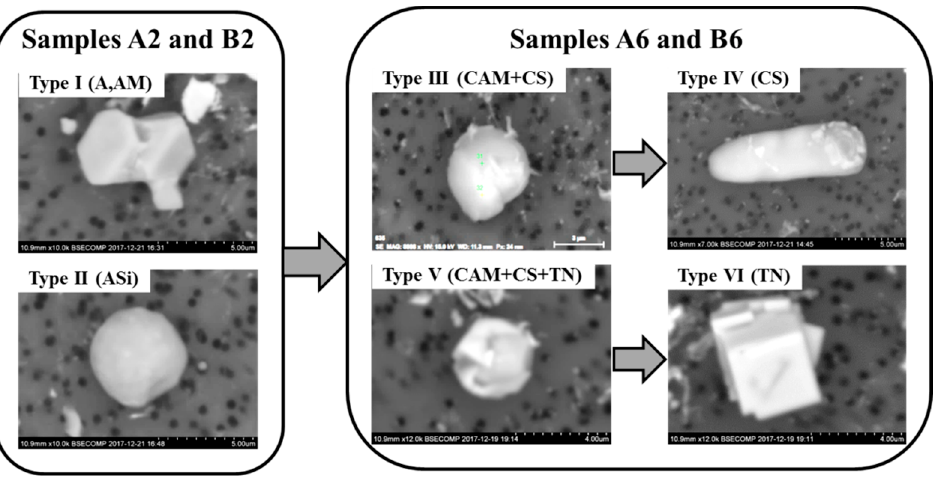
Figure 8. Modification of oxide inclusions by Ca-treatment of oil-pipeline steel.